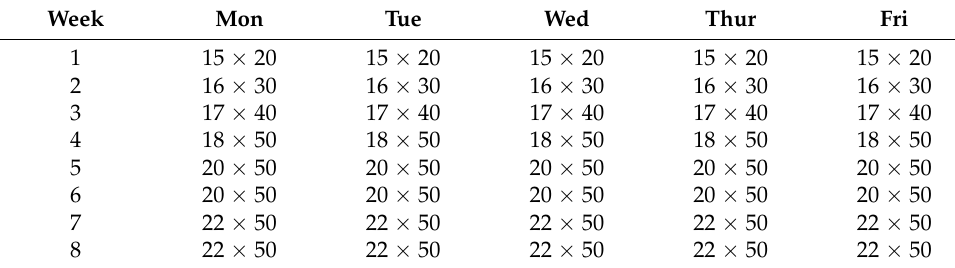
Table 1. Exercise intervention program for 8